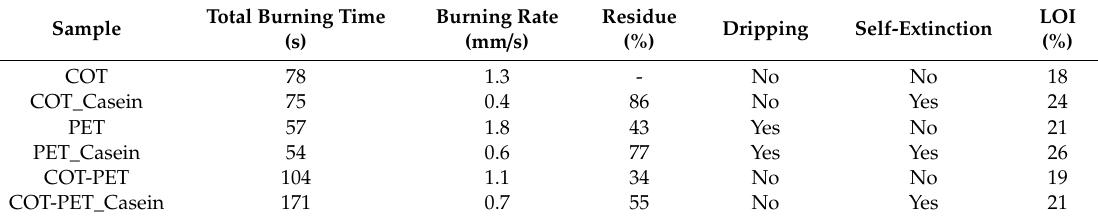
Table 4. Results for untreated and caseins-treated fabrics from horizontal flame spread tests.